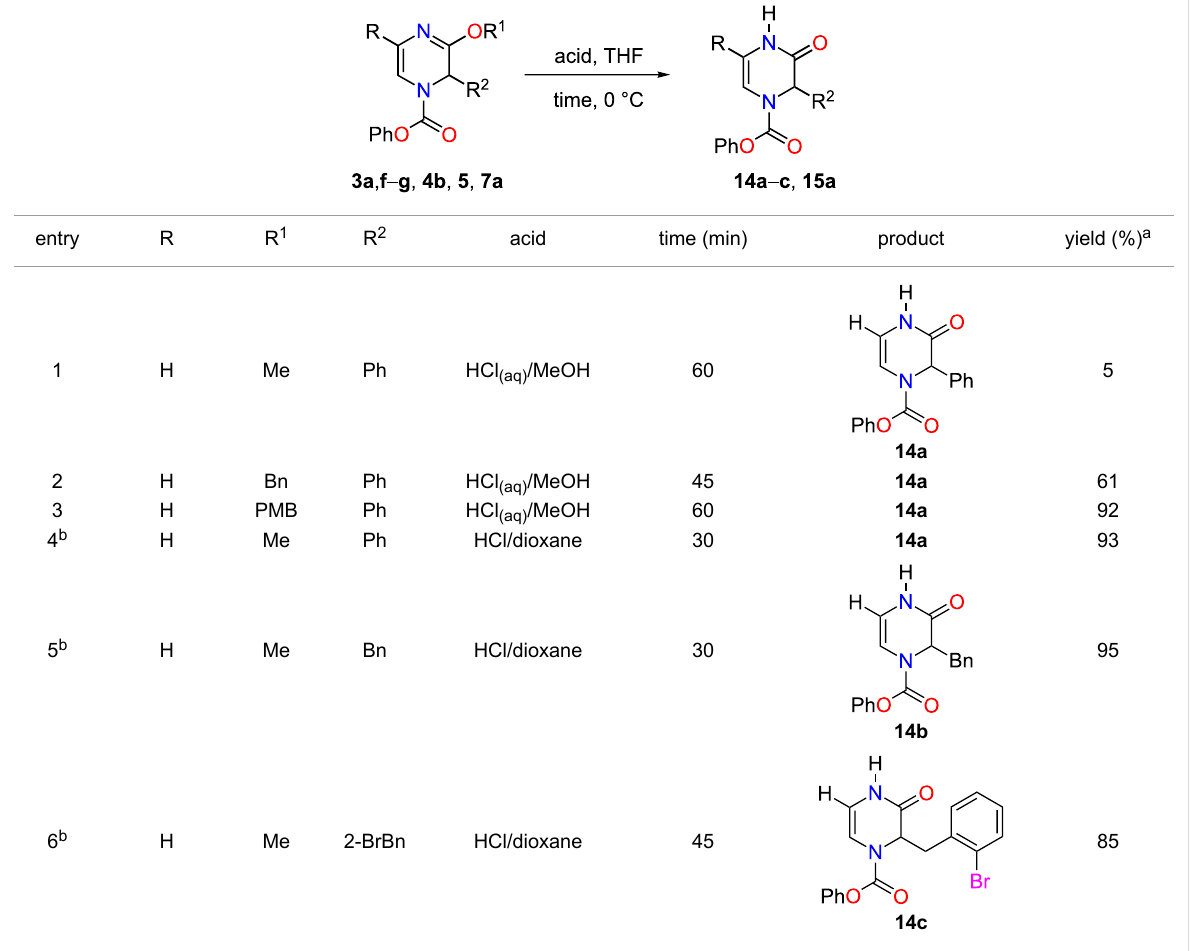
entry R R 1 R 2